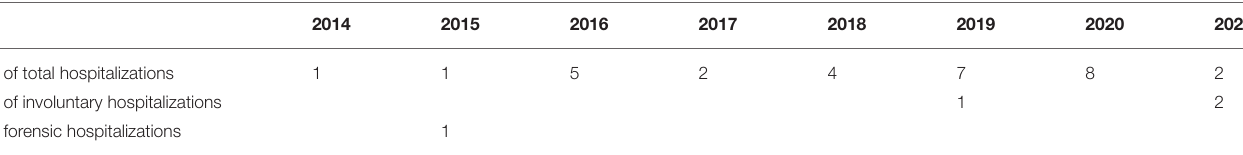
TABLE 1 | Number of admissions from 2014 to